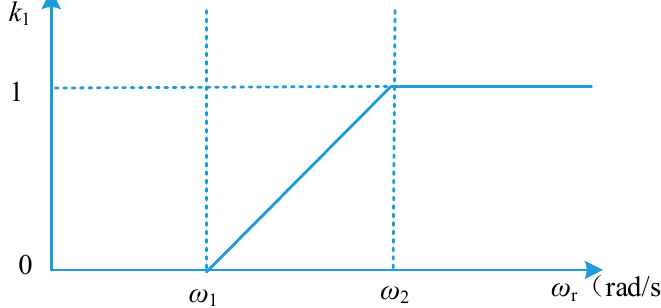
Figure 6. Relationship between weight coefficient k1 and resolver rotor frequency ω r . [T dq+1 ] and [T dq − 1 ] in Figure 5 represent the park transformation matrices of the positive sequence coordinate system and the negative sequence coordinate system, respec- tively. They represent the transformation relationship of components from static coordinate system to forward (reverse) rotating coordinate system. After transformation, the d-q axis voltage components in the positive sequence and negative sequence coordinate systems are obtained, respectively. As shown in Formula (7), they are coupled to each other, where ε is an arbitrary quantity, which satisfies the relationship of Equation (7).